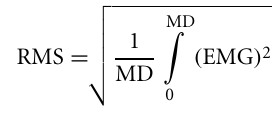
FIGURE 2 |Average durations ( ± SE) for the D-Right and the ND-Left arms of both groups during imagined and actual arm movements . Asterisks (*) indicate significant differences ( P <